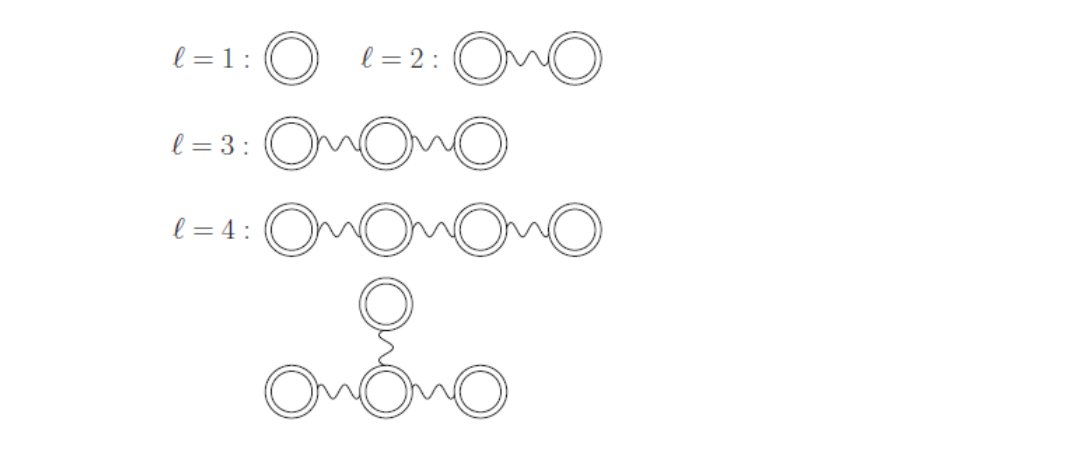
Figure 8. The 1PR effective action shown up to four loops summed up in [112]. Double solid line shows electron Green function dressed by the background field. The wavy line shows photon Green